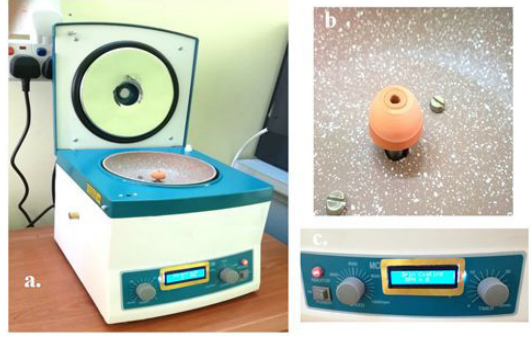
Figure 4. a. The final design of the spin coater, b. substrate holder, and c. front view of the spin coater speed controller.